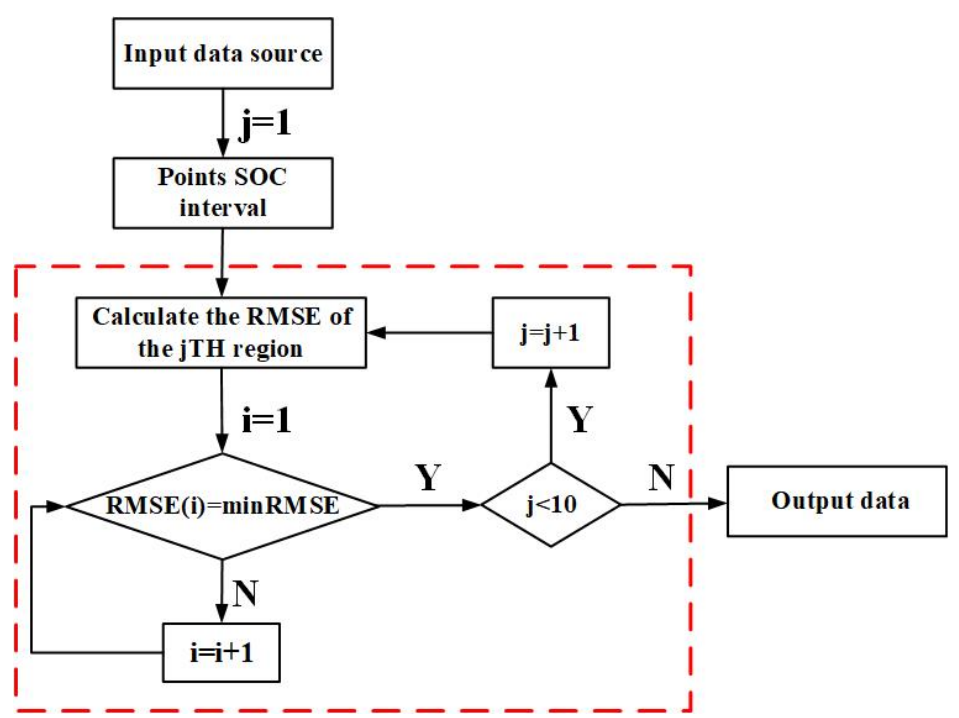
Figure 4. Flow chart of two-layer fusion model. (The red dashed box in the figure shows the algorithm cycle process). Table 5. Selection of two-layer fusion model of different SOC